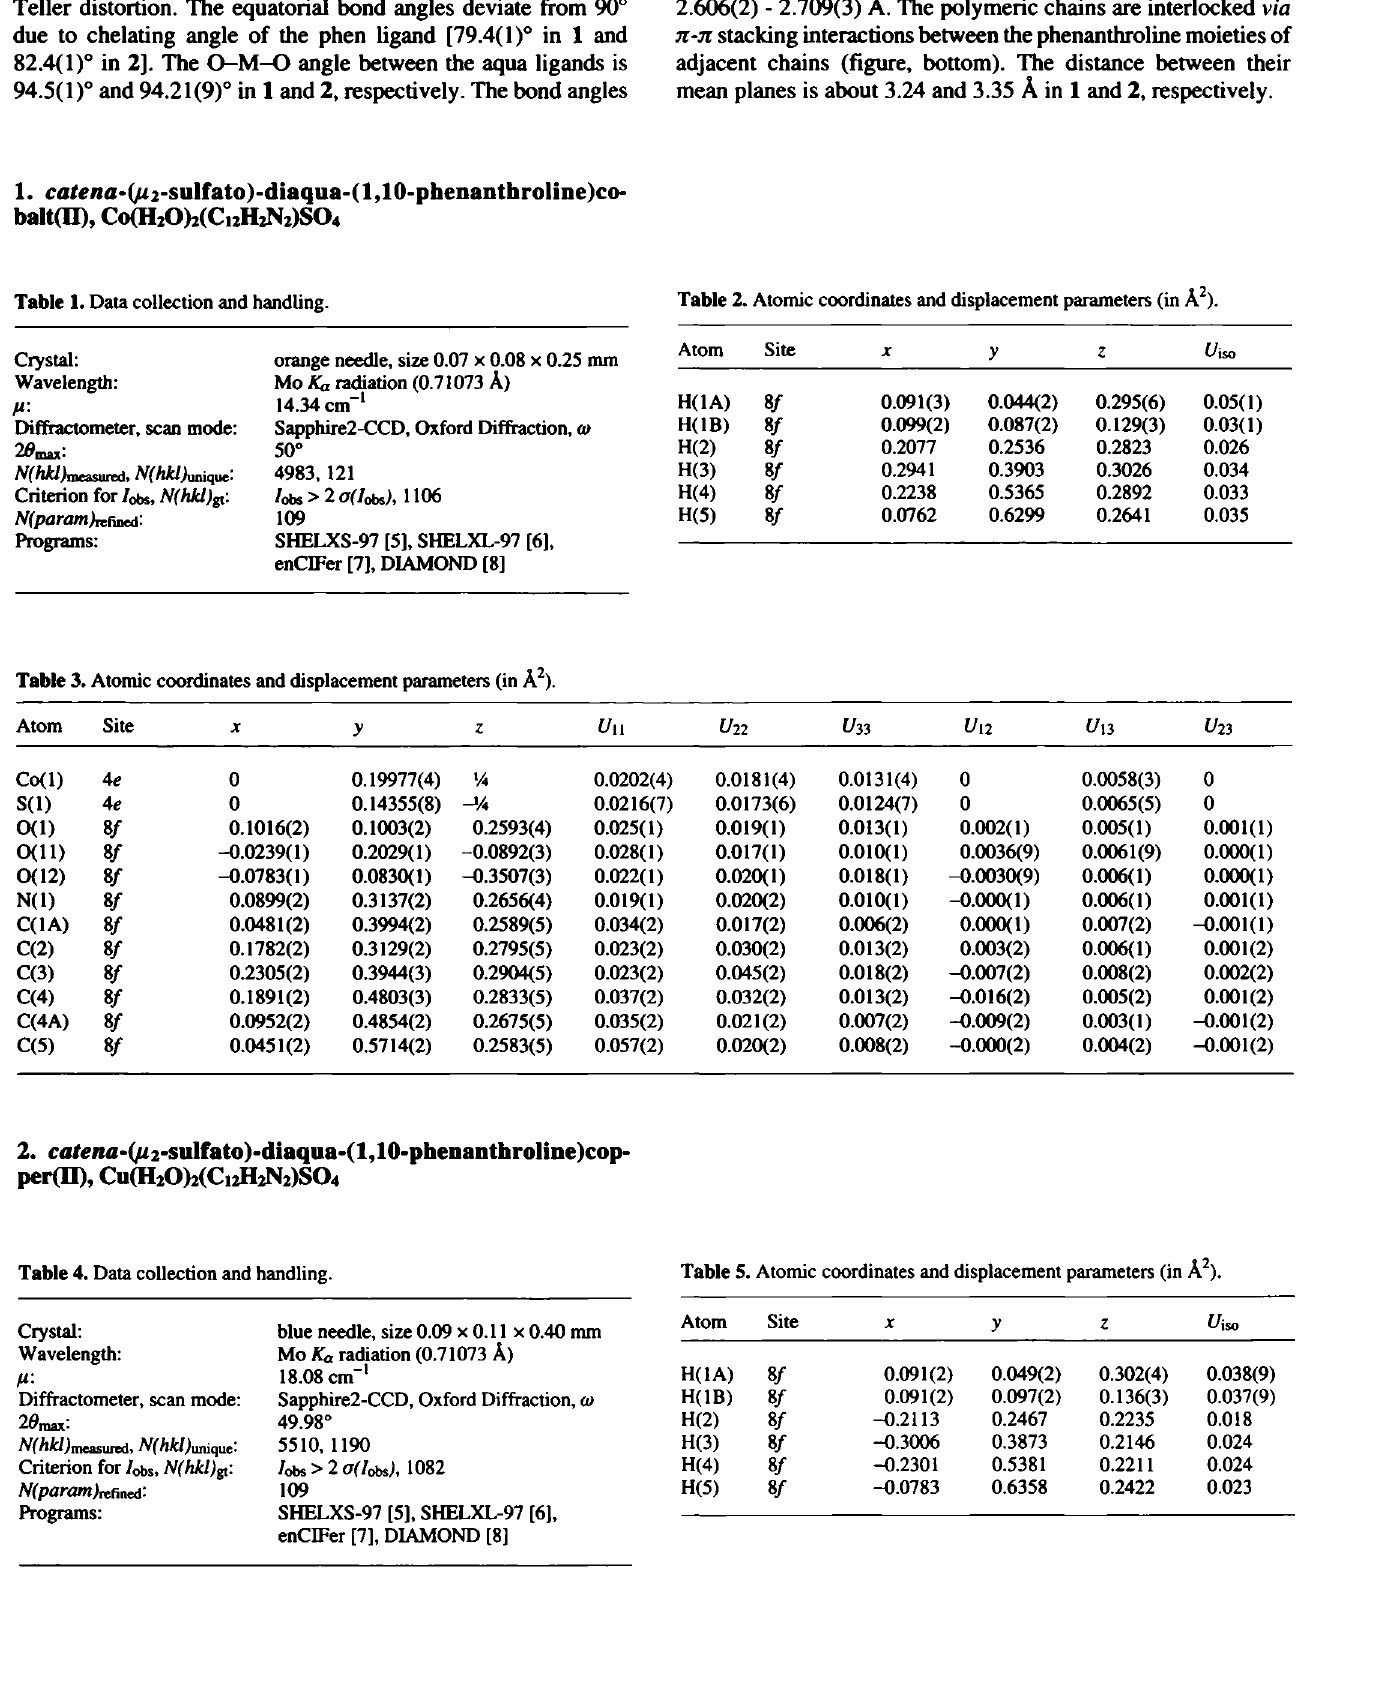
Table 4. Data collection and handling. Table 5. Atomic coordinates and displacement parameters (in Â 2